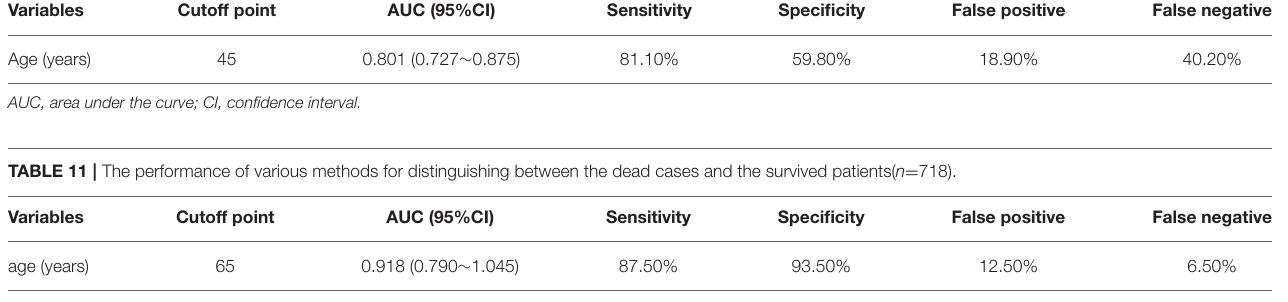
AUC, area under the curve; CI, confidence